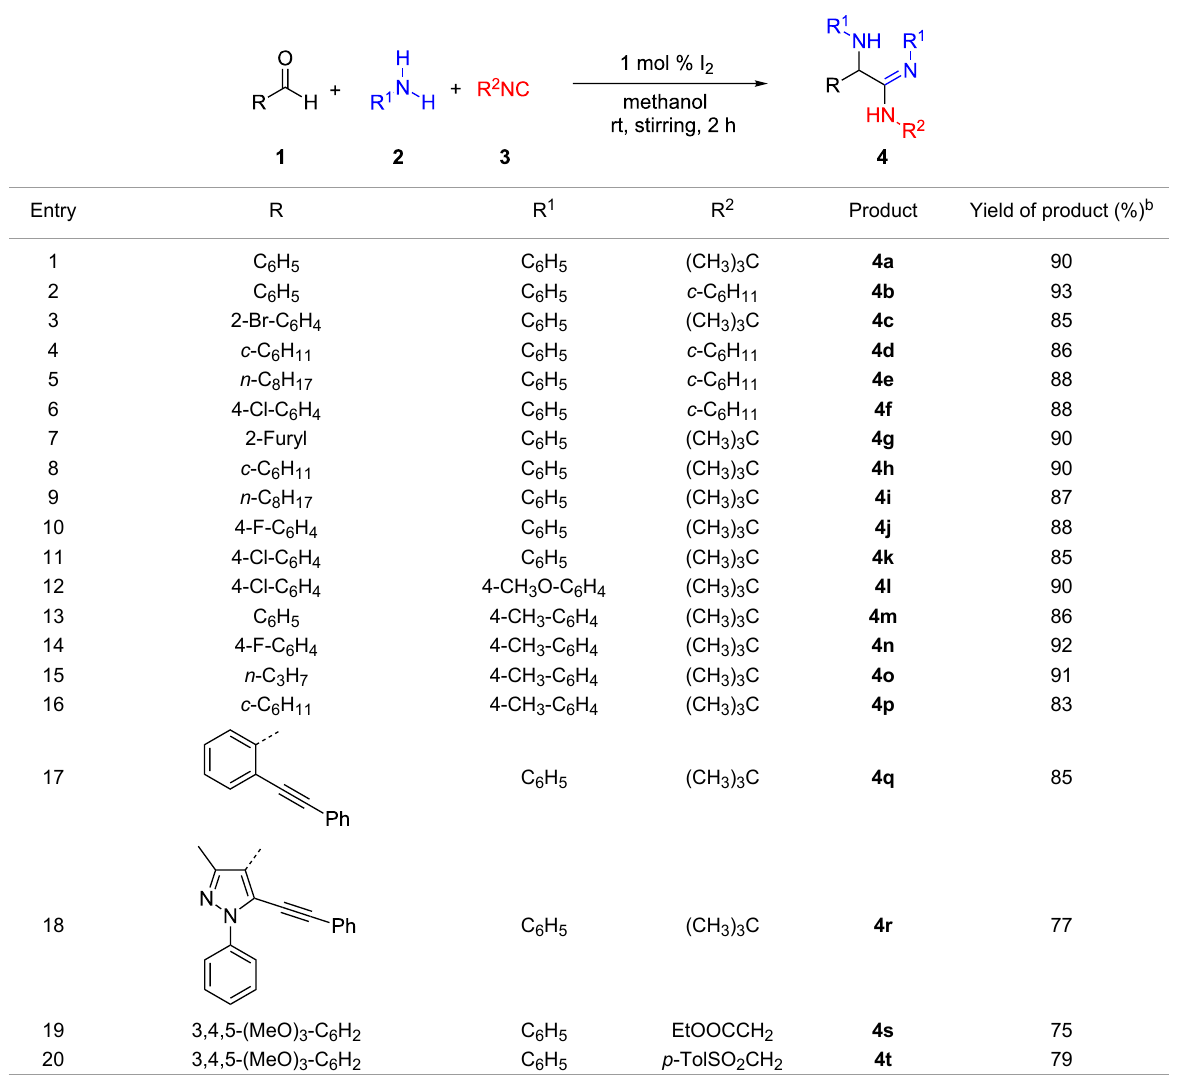
Table 2: Scope of the α -amino amidine synthesis through three-component coupling of aldehyde, amine, and isocyanide.